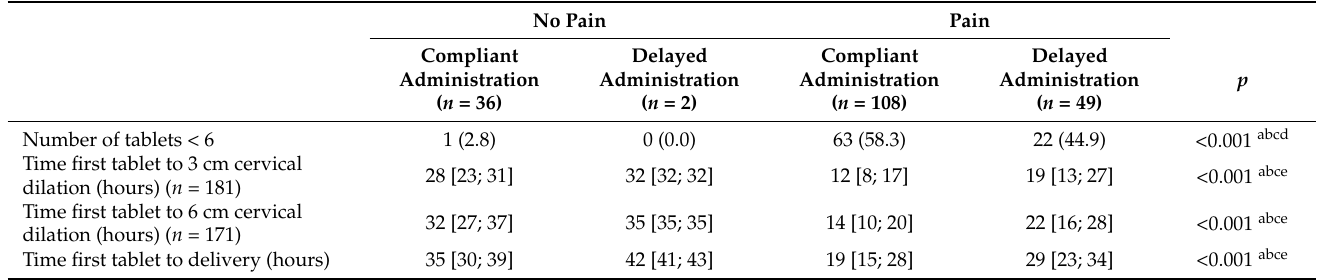
Table 5. Labor progression timeline according to pain and protocol